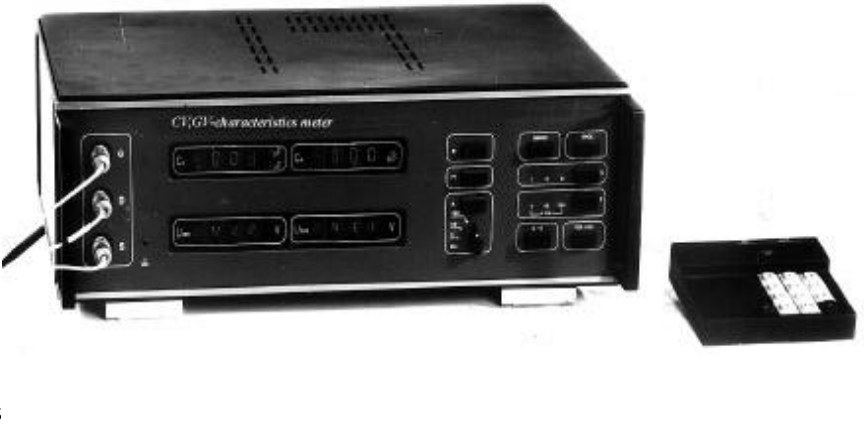
Figure 6. C-V , G-V meter for control of semiconductor